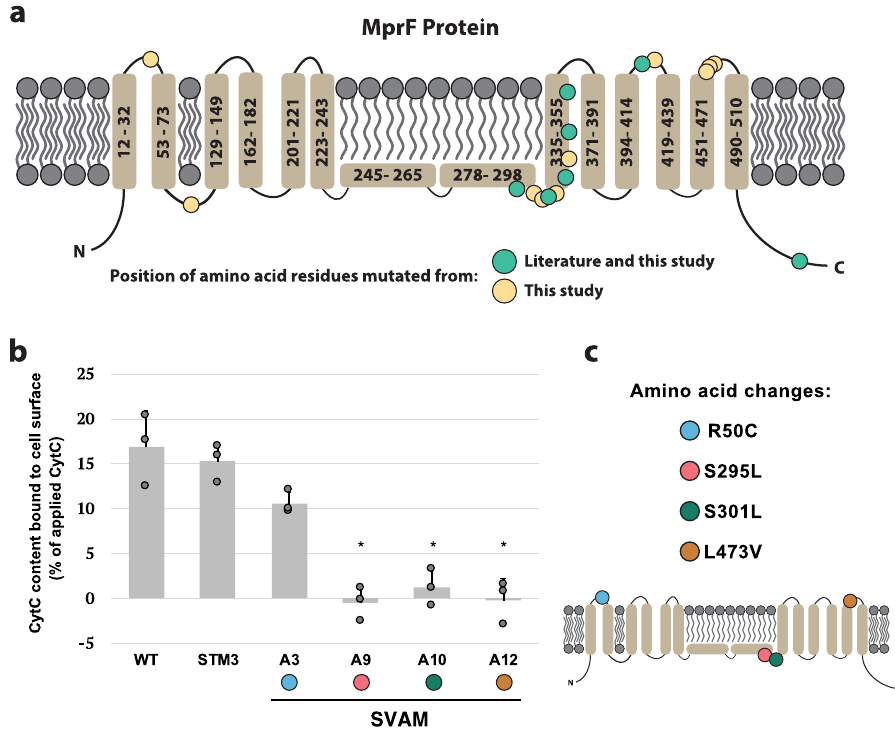
Fig. 6 MprF mutations and their effect on cell surface charge. a Topology of the MprF membrane protein and mapping of mutations identi fi ed in this dataset (yellow and green circles), in comparison to those previously reported (green circles) 62 . b A graph quantifying the cell surface charge of strains tolerized to vancomycin, in comparison to their starting strain counterparts, n = 3 biologically independent samples. Values that are signi fi cantly different ( P ≤ 0.05) from the value for the respective starting strain (WT or STM3) by Student ’ s t -test are indicated by an asterisk. Error bars represent one standard deviation. c Identi fi ed locations of the speci fi c amino acid substitutions observed in the tolerized strains and their position in the MprF structure. These mutations correspond to the strains tested in panel ( b ). STM: Staphylococcus aureus adapted to CA-MHB. SVAM: Staphylococcus aureus tolerized to vancomycin in